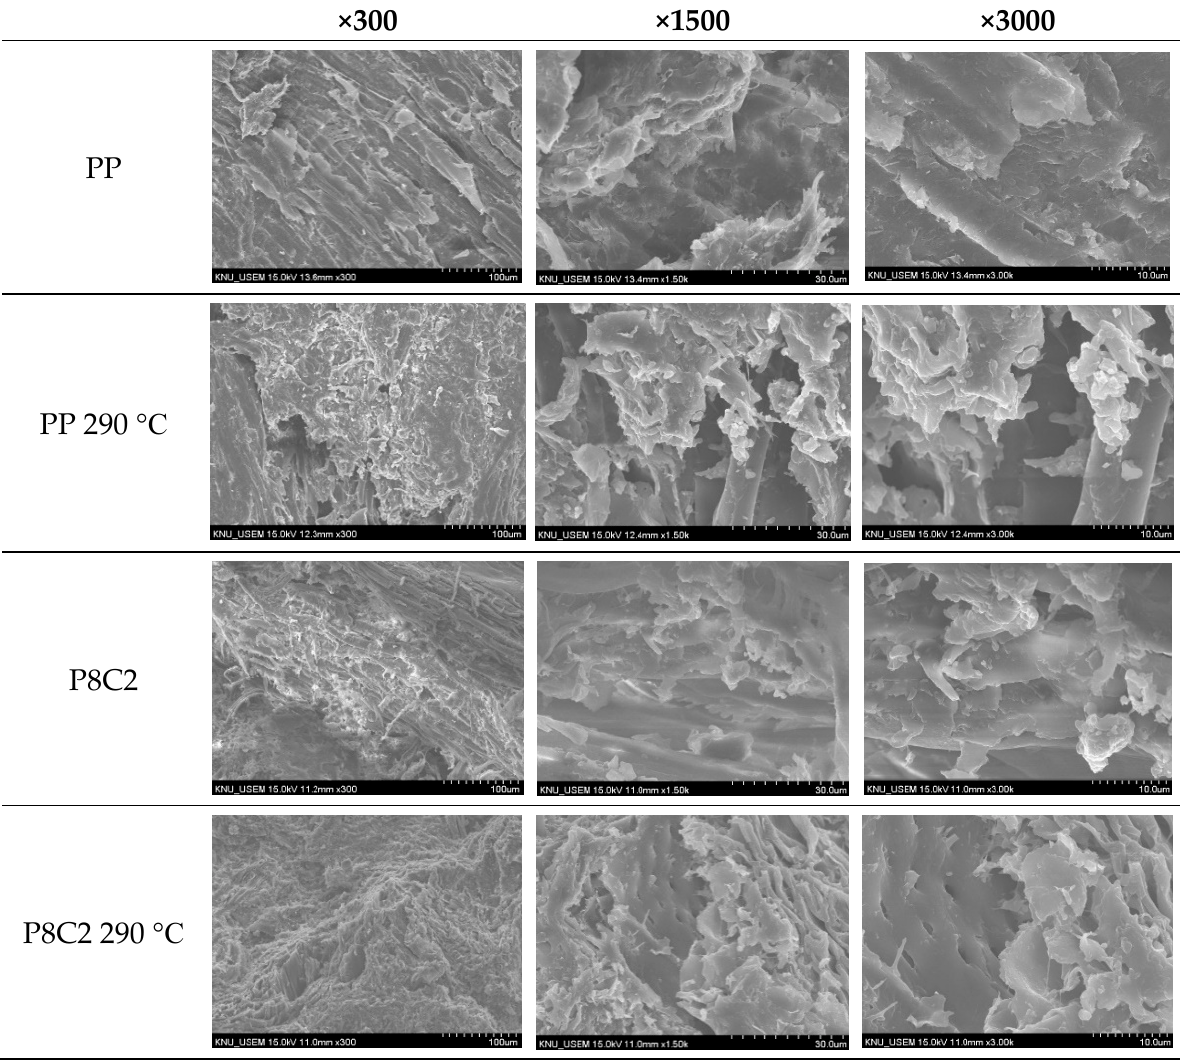
Figure 3. SEM images of untreated and torrefied pellets.